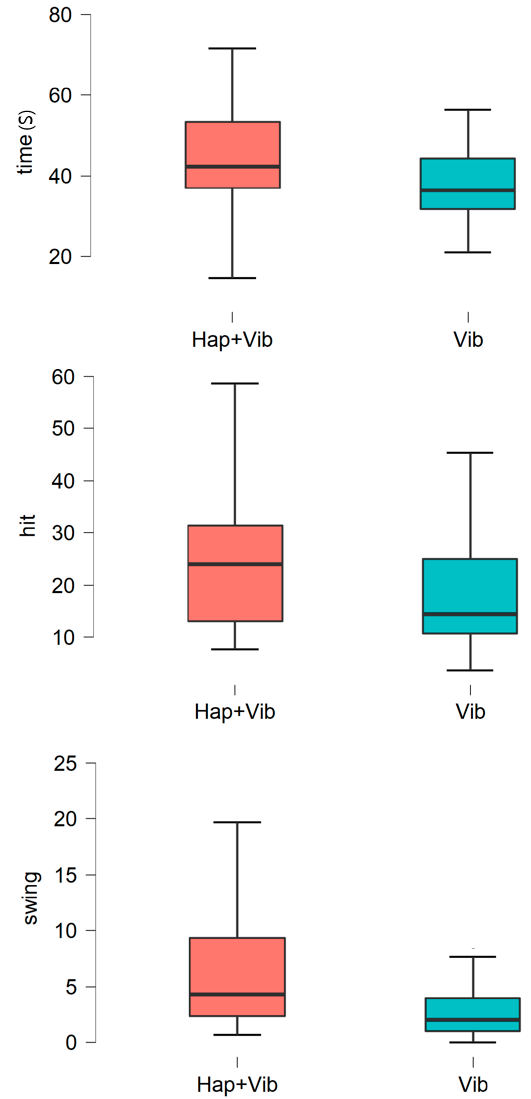
Figure 11. Averages for time (seconds), hit score per unit time, and swing score per unit time.